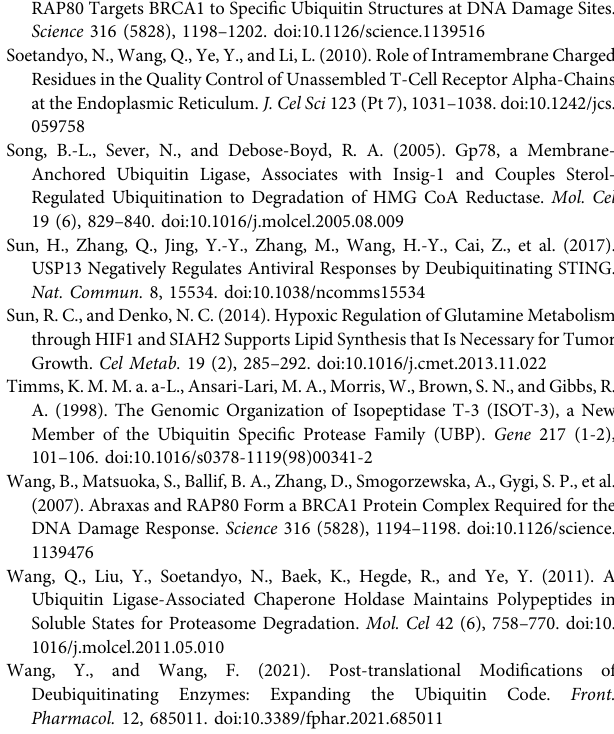
Suppression: Figure 1. Cancer Discov. 2 (8), 679 – 684. doi:10.1158/2159-